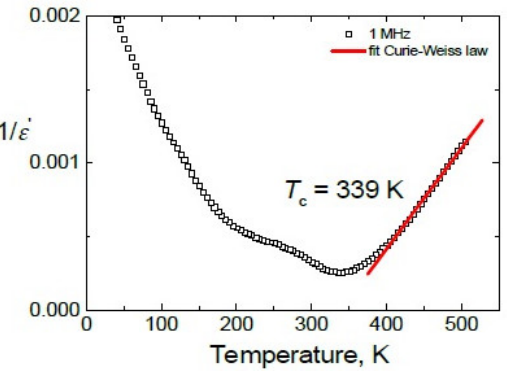
Figure 6. Temperature dependence of the reciprocal static dielectric permittivity.